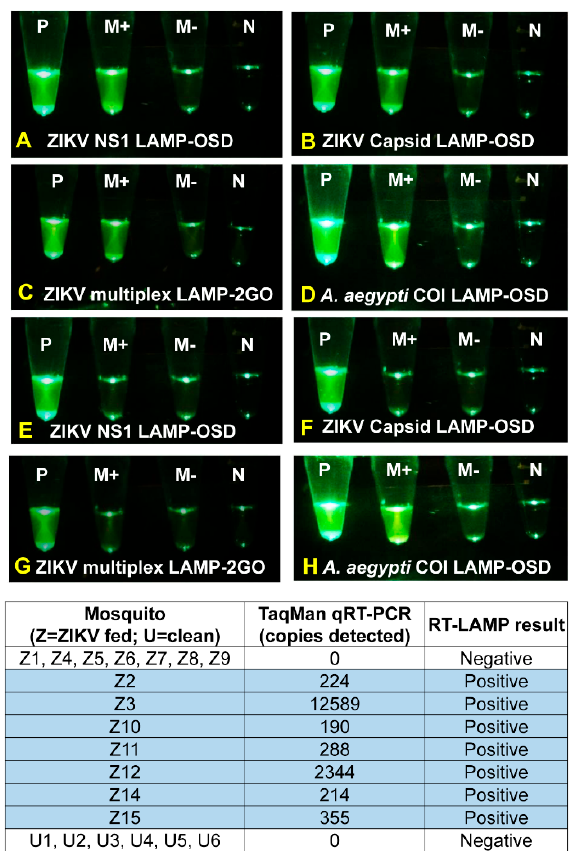
Figure 8. Detection of Zika virus-infected mosquitoes using individual- and multiplex degenerate reverse transcription LAMP assays. Zika virus-infected (panels A – D ) and uninfected (panels E – H ) Aedes aegypti mosquitoes were directly analyzed using NS1 and capsid LAMP-OSD assays or with multiplex LAMP-2GO assays. As a positive control, mosquitoes were tested using the A. aegypti coi LAMP-OSD assay (panels D and H ). Smartphone images acquired after 2 h of amplification are depicted. P: positive control; M+: mosquito analyte with LAMP primers; M-: mosquito analyte without LAMP primers; N: no template control. Results of NS2b TaqMan qRT-PCR analysis of all mosquitoes are tabulated.